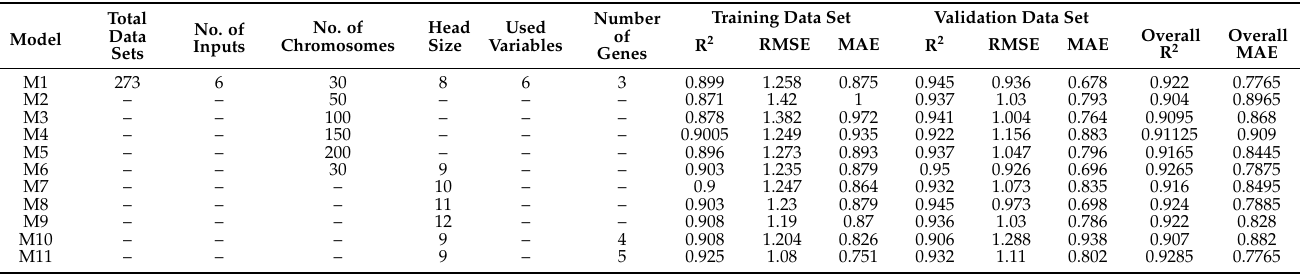
Table 2. Details of the trials scrutinized in this